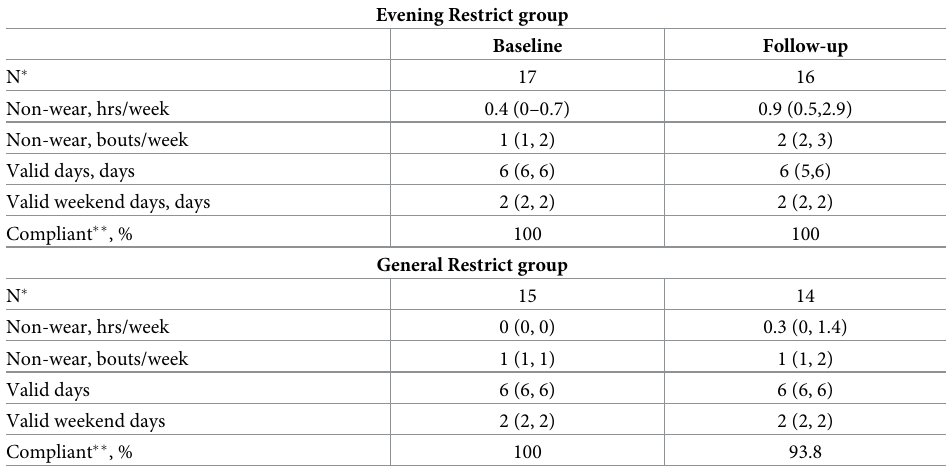
Summary statistics above are medians with 25 th and 75 th